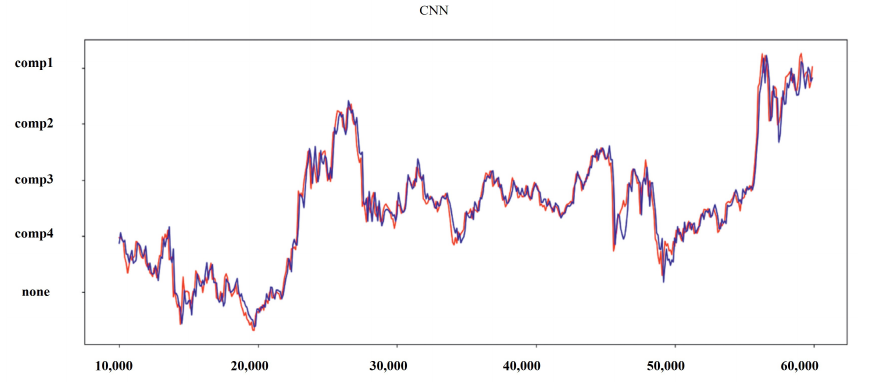
Figure 8. Results for the predicted values and real values for CNN.